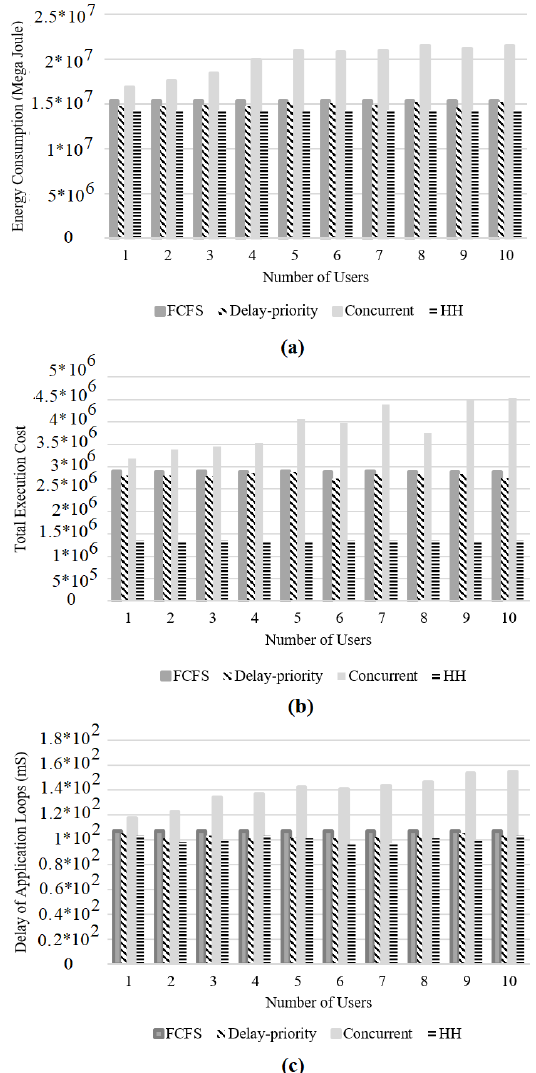
Figure 4. Comparison of scheduling algorithms based on number of users: ( a ) Energy consumption, ( b ) Total execution cost, and ( c ) Delay of application